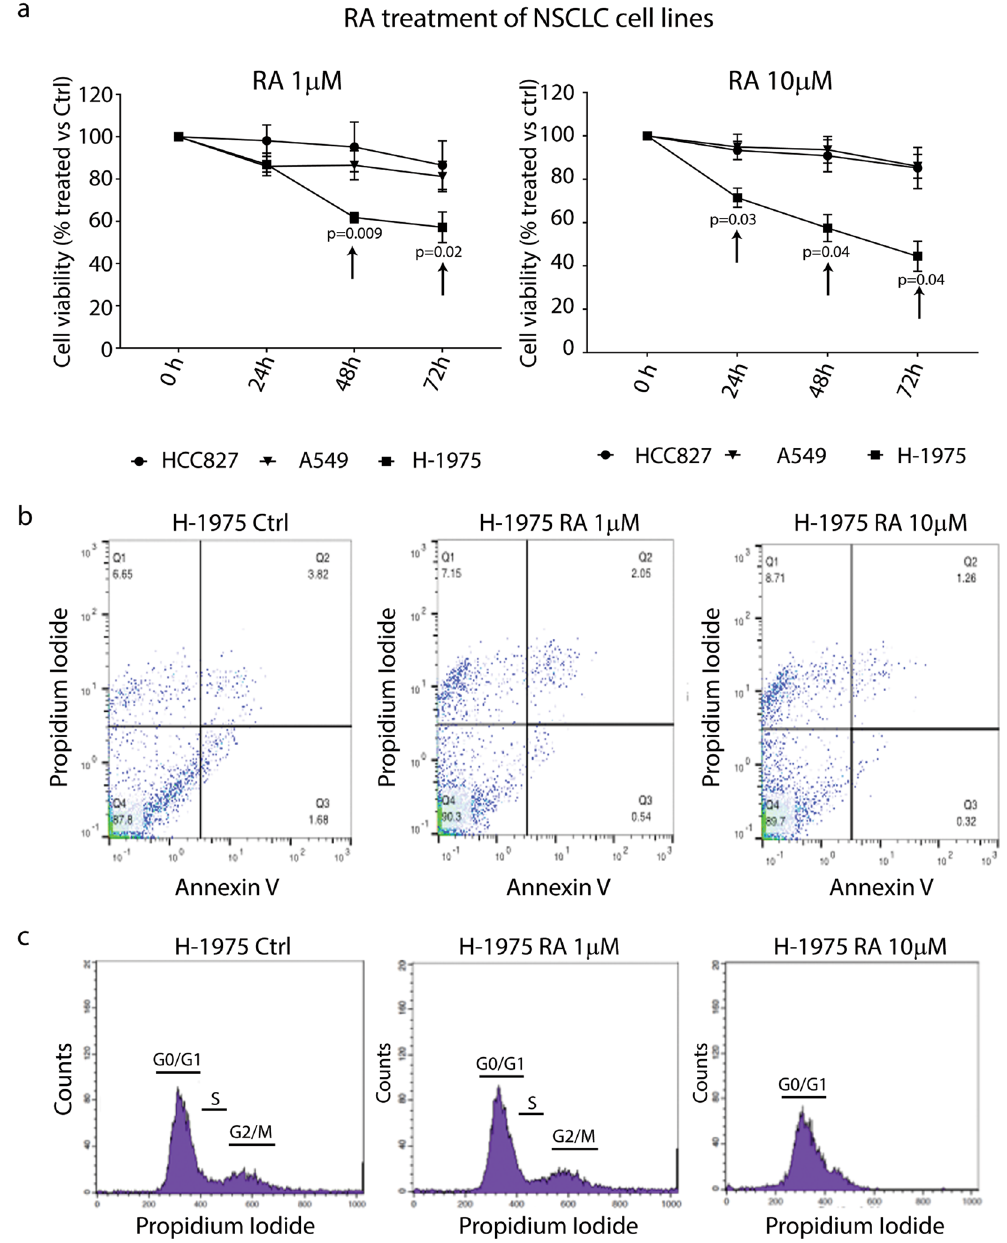
Figure 1. Retinoic Acid affects the growth of TKI resistant NSCLC cells. (a) Cell viability assay (MTT) of A549, HCC827 and H-1975 NSCLC cell lines treated with 1 and 10 µ M RA for 24–48 and 72 hrs. Black arrows indicate the effect of RA on the TKI resistant H-1975 NSCLC cell line (right and left panel). Data are represented as mean ± SD and indicate the percentage of RA treated cells versus an untreated control (n = 4). (b) Representative Annexin V/PI assay analyzed by FACS to assess whether RA treatment induces apoptosis in H-1975 cells (n = 3). (c) Cell cycle analysis of H-1975 NSCLC cells treated with 1 and 10 µ M RA for 72 hours (n = 4). Statistical analysis has been obtained by unpaired multiple t